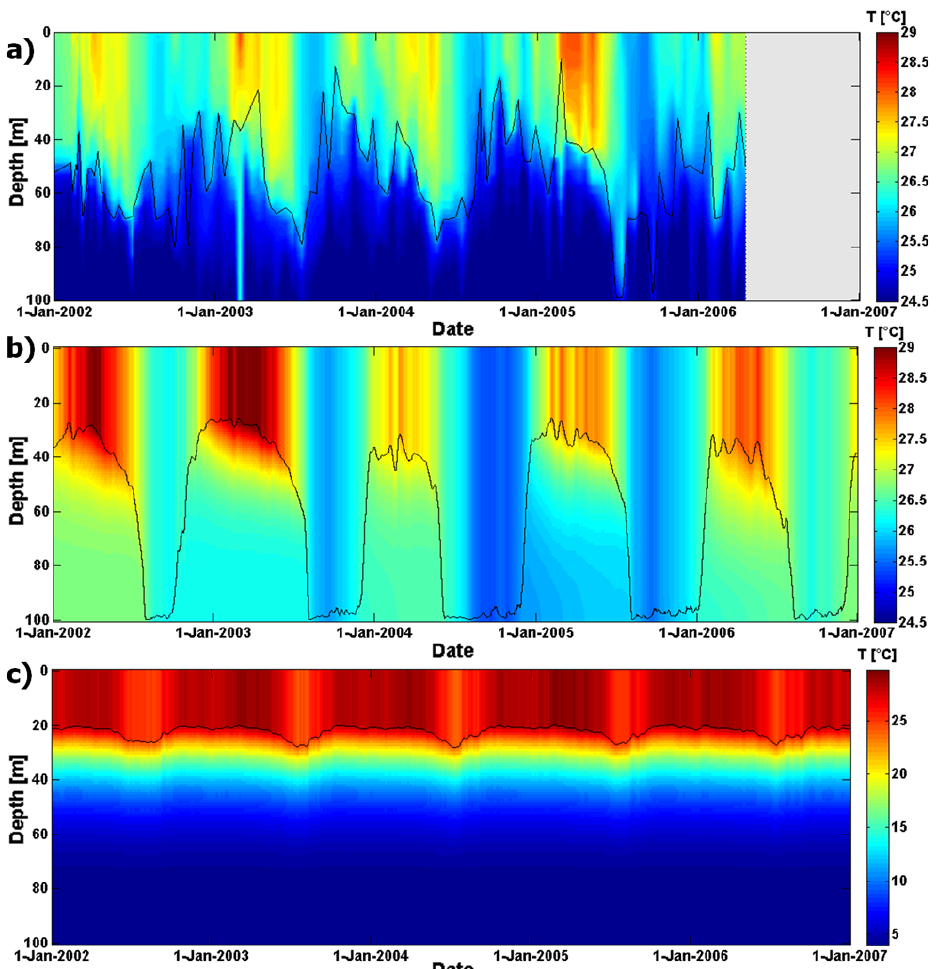
Fig. 7. Lake water temperatures ( ◦ C) at Kigoma (northern basin of Lake Tanganyika) (a) from observations, (b) as predicted by the AWS- driven FLake-control, and (c) as predicted by FLake-ERA-Interim. The black line depicts the mixed layer depth (Sect. 2.3; weekly mean for the simulations). Note the different colour scaling in (c)